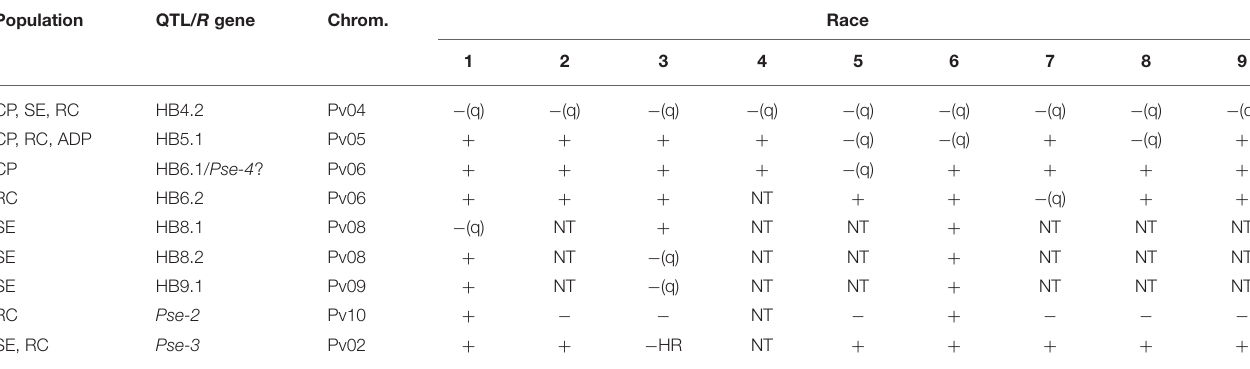
TABLE 1 | Interaction phenotypes exhibited by halo blight-resistant Phaseolus vulgaris lines of the SOA-BN × Edmund (SE), Canadian Wonder × PI 150414 (CP) and Rojo × CAL 143 (RC) recombinant inbred populations and the Andean Diversity Panel (ADP) following inoculation with different races of Pseudomonas syringae pv. phaseolicola , with QTL and predicted resistance ( R ) genes indicated. Population QTL/ R gene Chrom.